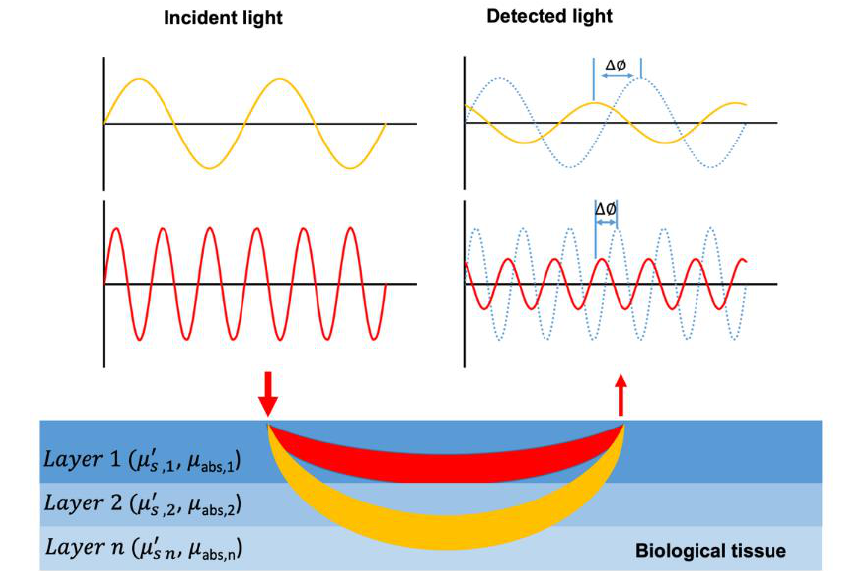
Figure 12. Schematic representation of NIR light penetration for both low and high modulation frequency. The figure illustrates two detected signals successively along with the possible photon paths “banana shape” in different layers with various absorption coefficient and reduced scattering coefficient.